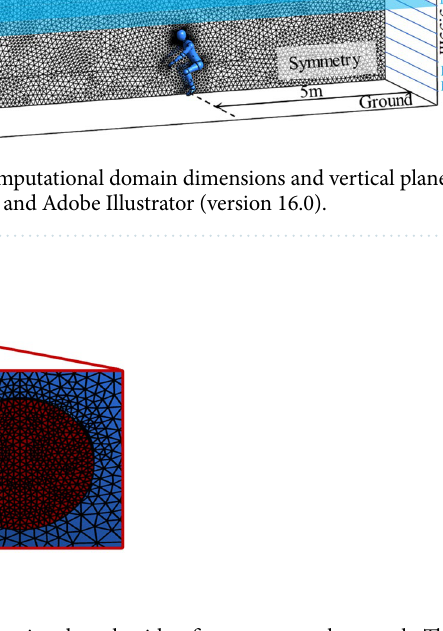
Figure 3. Computational mesh with refinement near the mouth. The figure was drawn in Tecplot 360 (version 2016 R2) and Adobe Illustrator (version